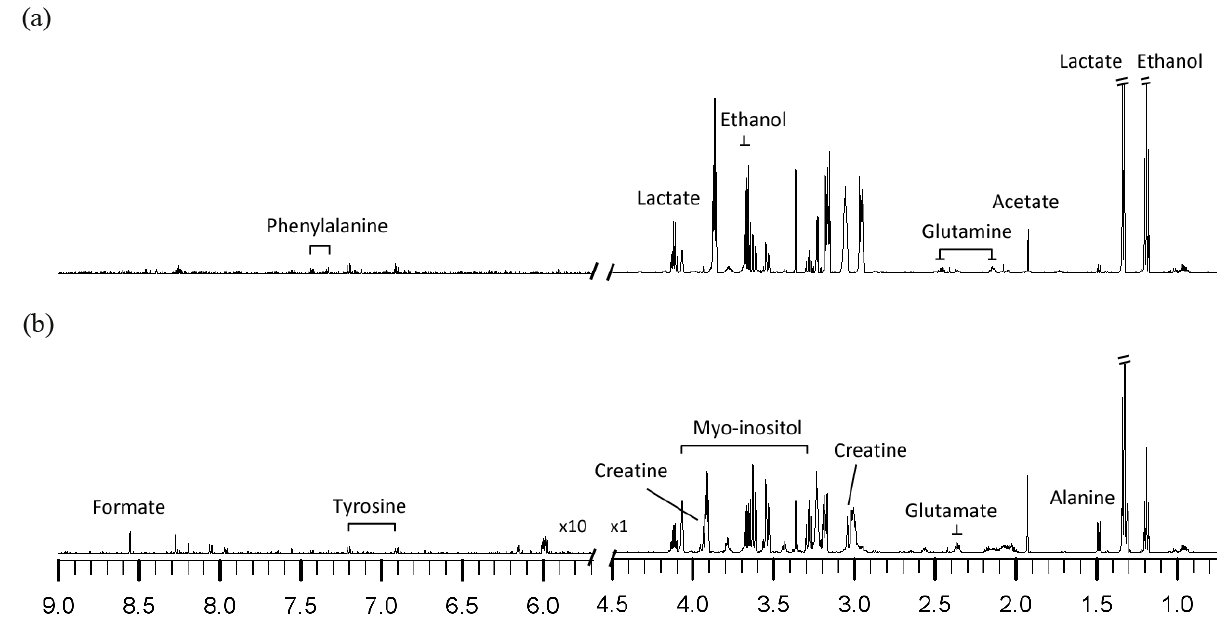
Figure 1. 1 H-NMR spectra of cell extracts obtained from MDA-MB-231 after 48 h treatments under ( a ) hypoxia, ( b )